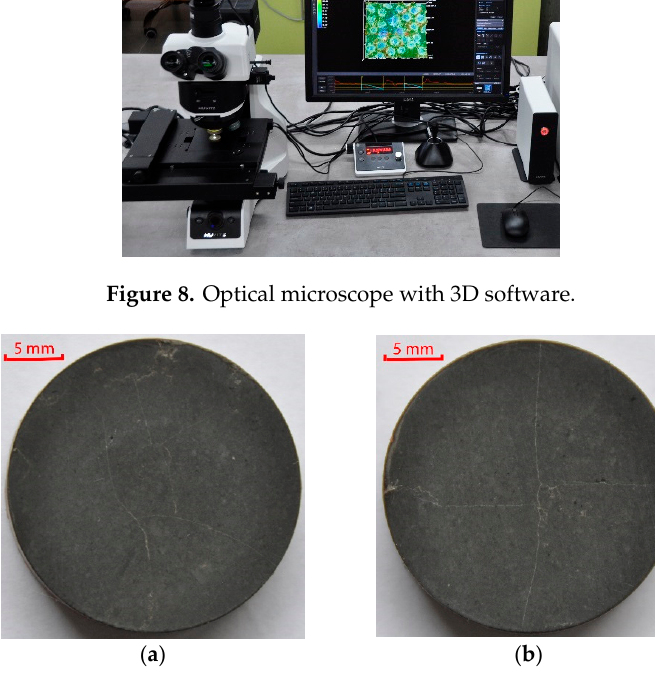
Figure 9. Surface of the core plug sample with a diameter of 2.54 cm before the embedment test: ( a ) Top; ( b ) Bottom.